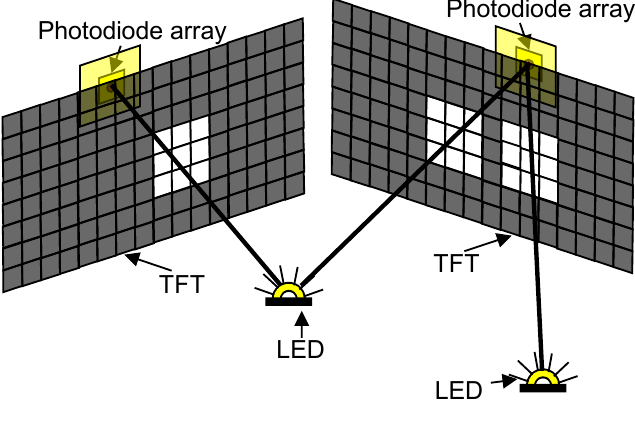
Figure 5. Theoretical scheme of the positioning